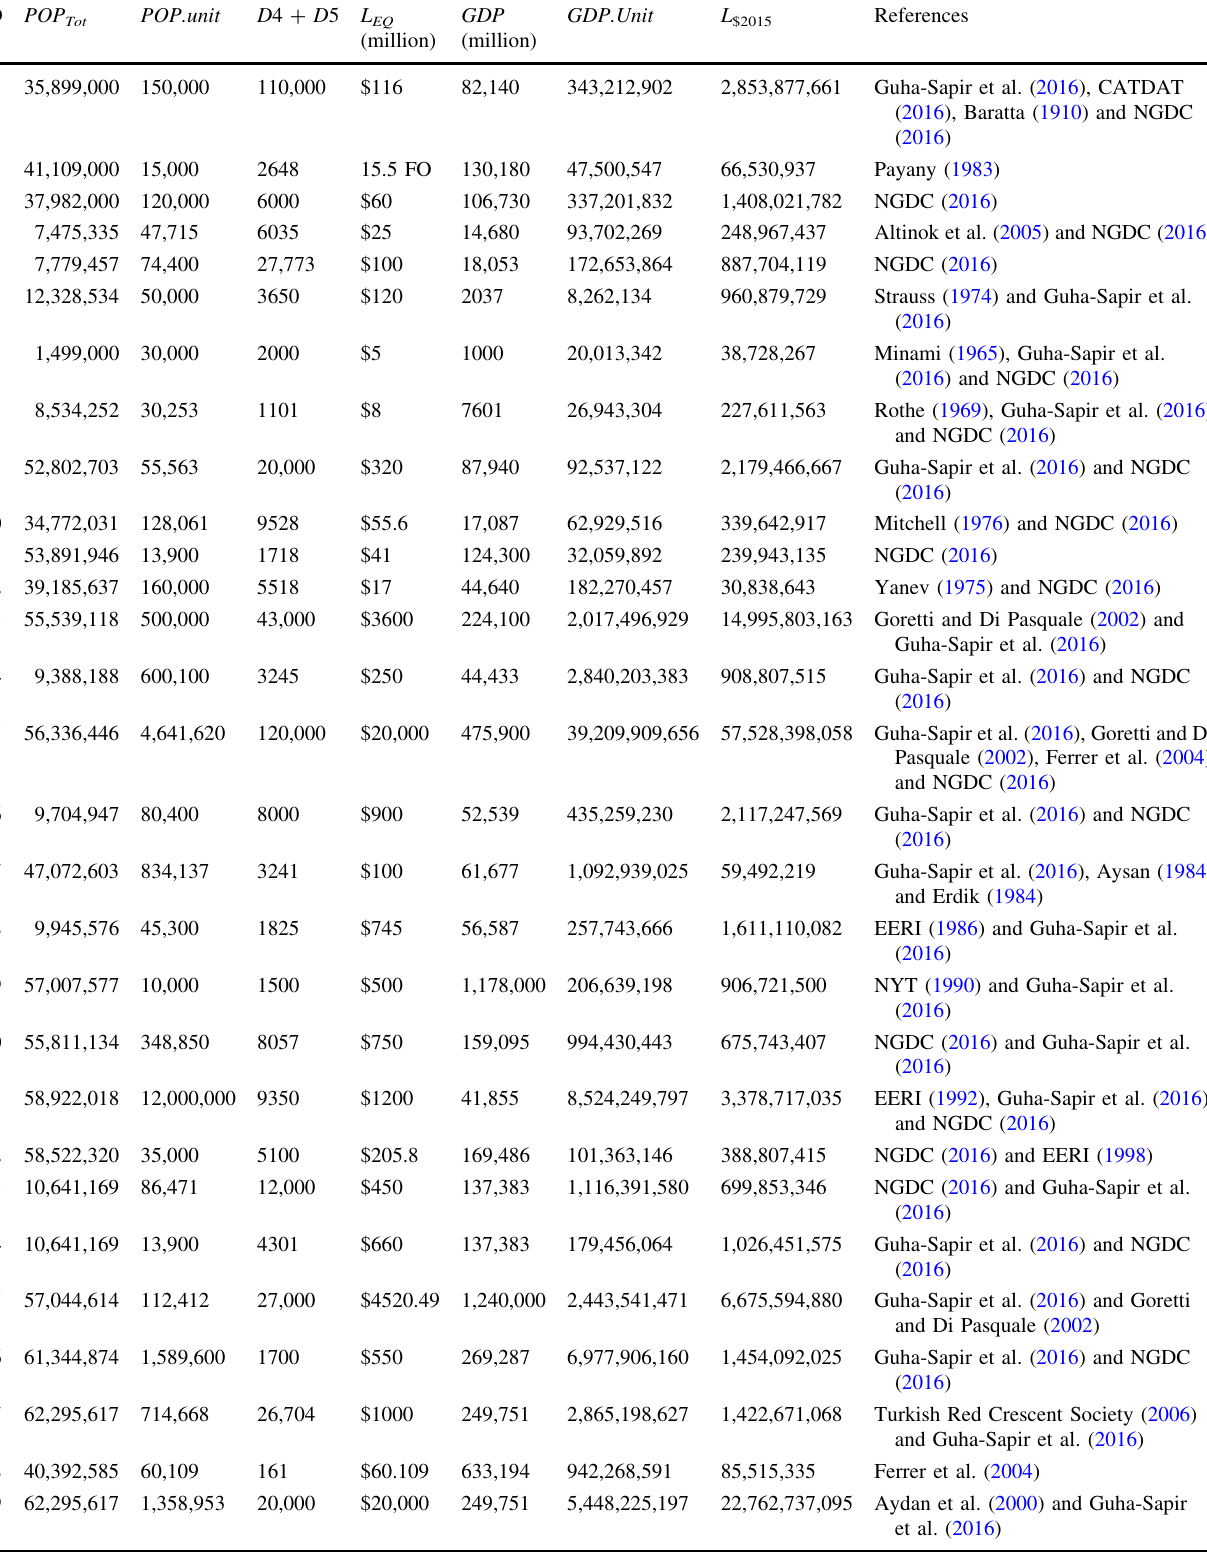
Table 2 Population and damage for the Mediterranean for the 1900–2015 earthquakes compiled in the database, with the Algerian earthquakes listed separately at the end ID POP Tot